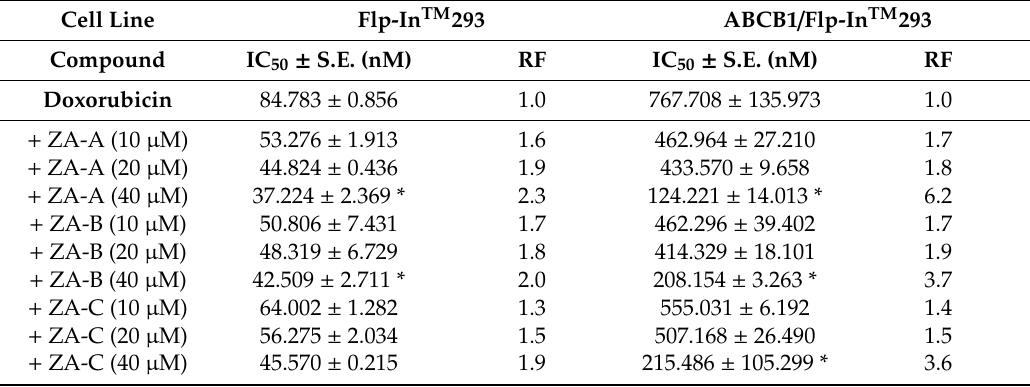
Table 1. The reversal e ff ects of ZA-A, ZA-B and ZA-C on chemotherapeutic drug resistance in P-gp over-expressing cell line ABCB1 / Flp-In TM